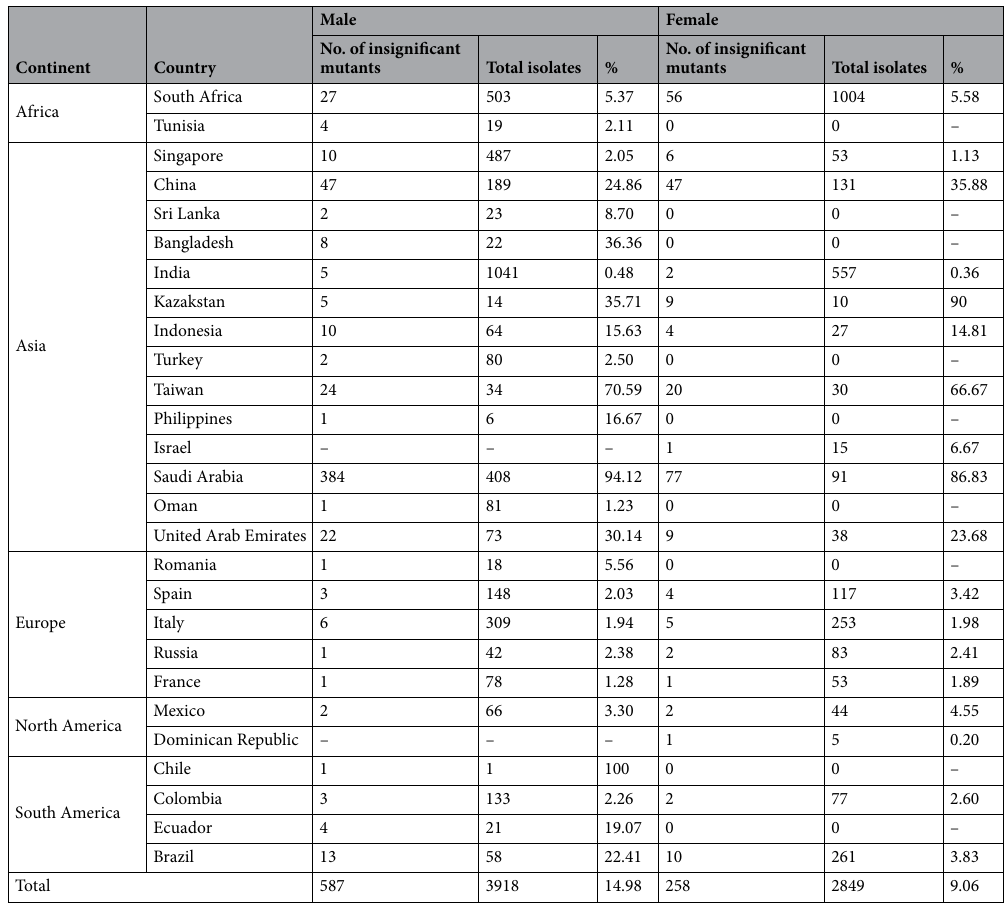
Table 3. Isolates with insignificant mutants across continents.